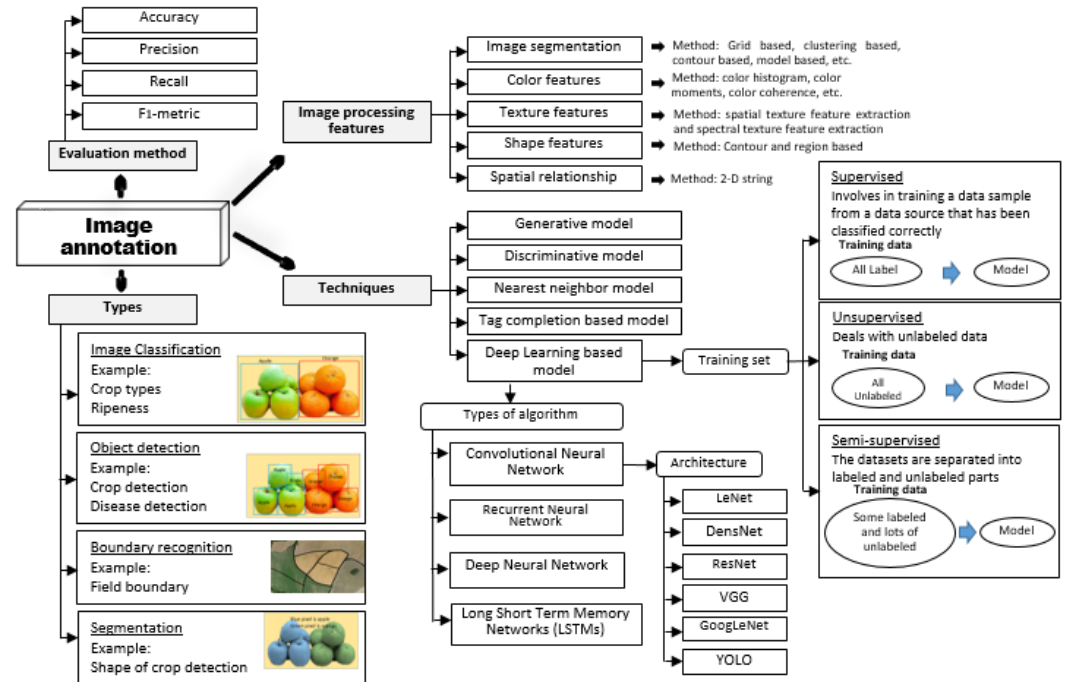
Figure 5. Image annotation for deep learning-based technique.